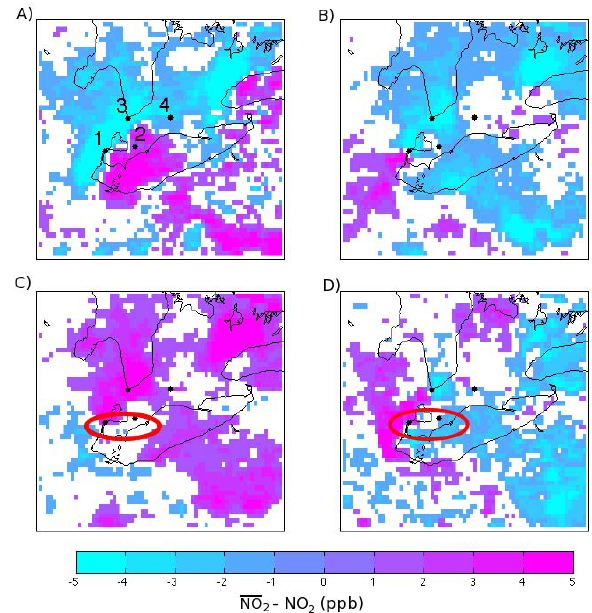
Fig. 13. Difference between OMI inferred NO 2 grouped by wind direction and annual average OMI inferred NO 2 . Purple (positive), indicates higher than average NO 2 concentrations when the wind blows from that direction while blue indicates lower than average concentrations. Uncoloured regions are less than 1ppb difference. Labeled points in (A) represent surface monitoring stations (1: WW and WD; 2: CH; 3: SA; 4: LO) (A) represents only OMI measure- ments taken when wind was blowing from the NW direction. ( B , C and D ) Same as (A) but NE, SW and SE directions, respectively. See text for in-depth description regarding marked areas in (C) and (D)